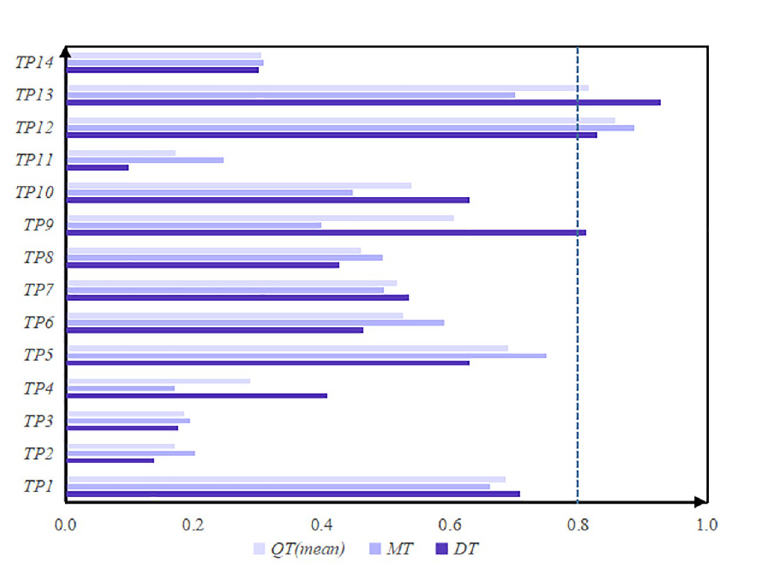
Fig 7. The importance of technical characteristics property